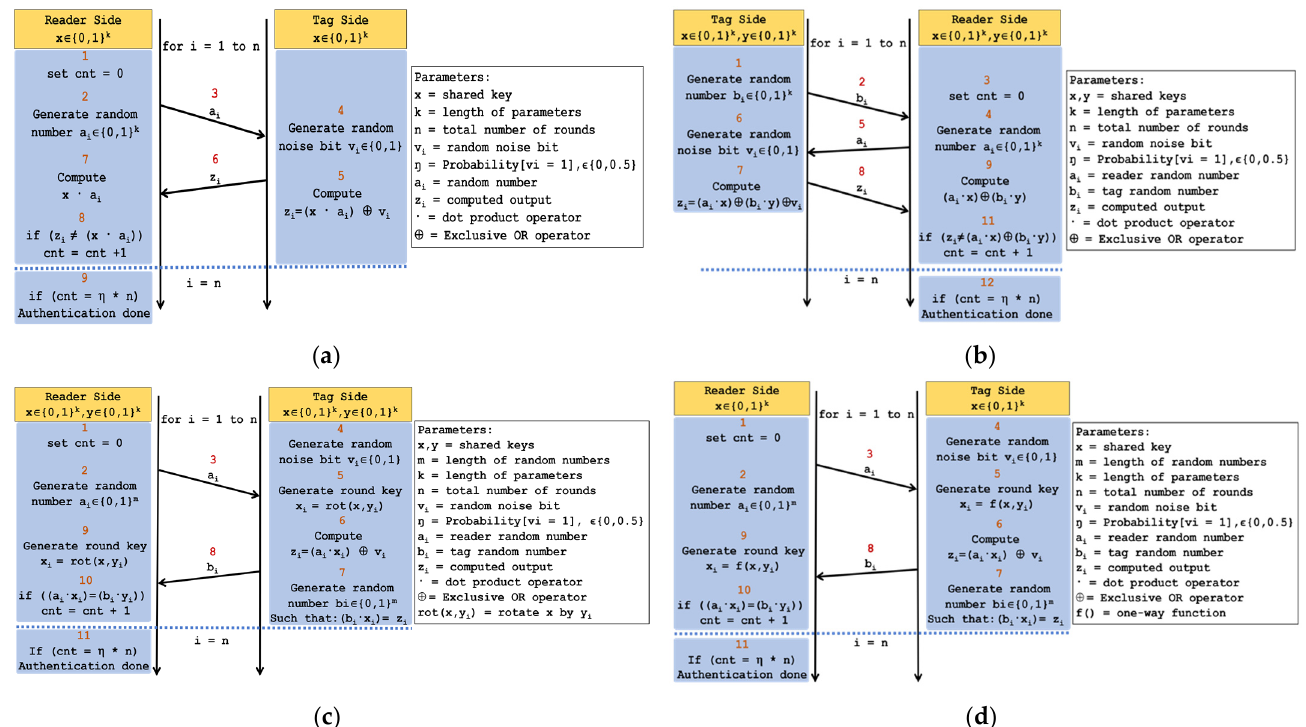
Figure 2. Algorithm flow of HB type lightweight authentication protocols: ( a ) HB protocol; ( b ) HB+ protocol; ( c ) HBMP protocol; ( d ) HBMP+ protocol.